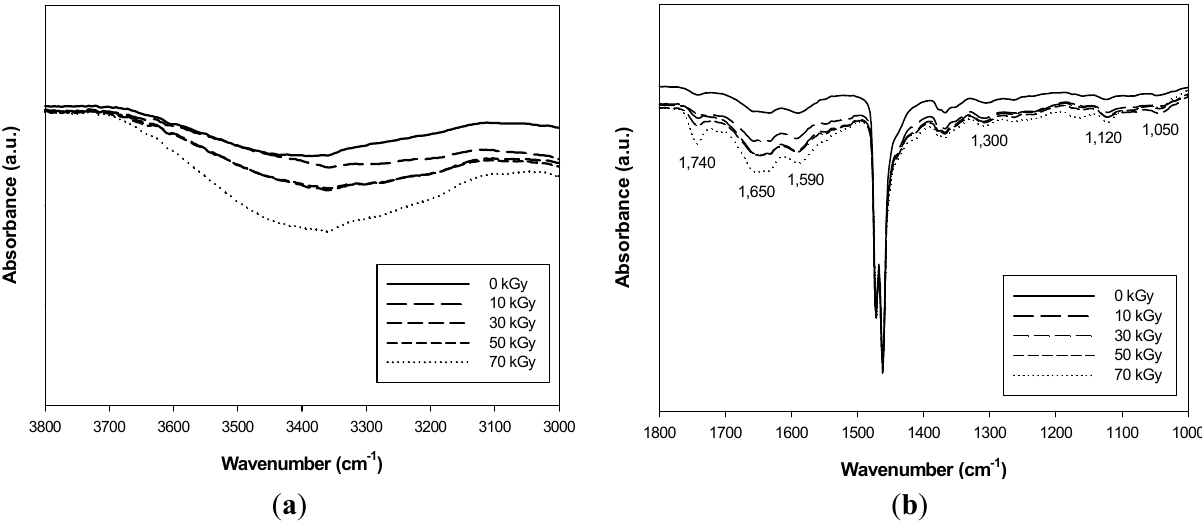
Figure 3. Fourier transform infrared spectroscopy (FT-IR) spectra of PU (1 phr)/HDPE composite at various absorption doses. ( a ) Wavenumber range 3800–3000 cm − 1 ; ( b ) wavenumber range 1800–1000 cm − 1